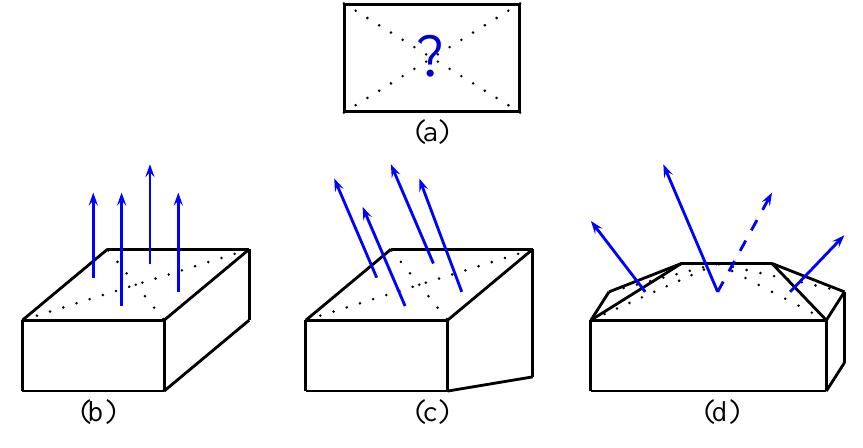
is known. (b) Estimated prismatic model (algorithm initialization). (c) Estimated